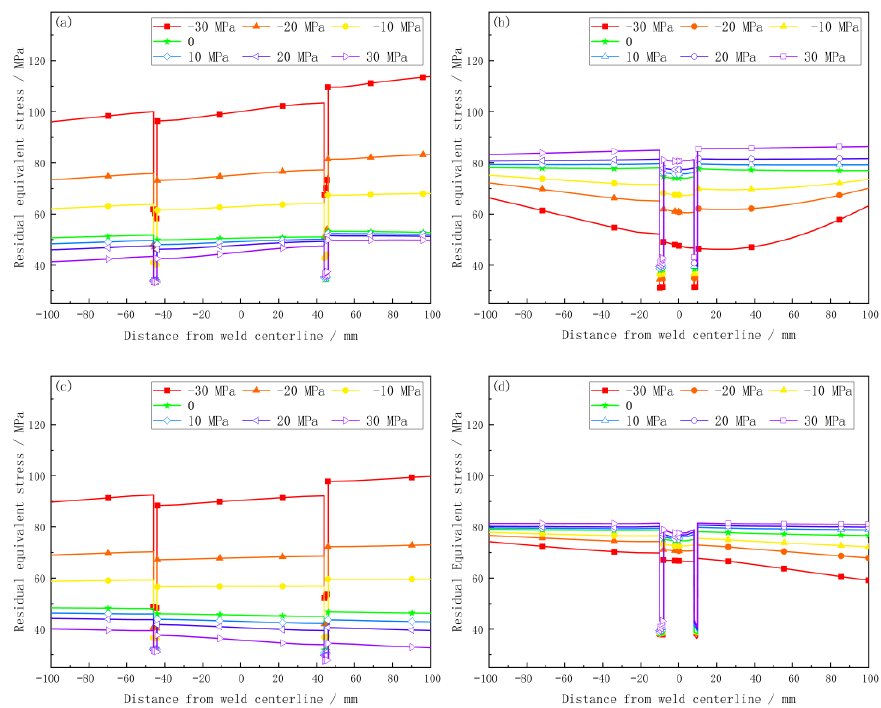
Figure 4. Effect of axial structural induced stress on equivalent stress of pipe to elbow welds: Figure 4 revised 2022.10.25 ( a ) 12:00 outside surface, ( b ) 12:00 position inside surface, ( c ) 6:00 outside surface, ( d ) 6:00 position inside